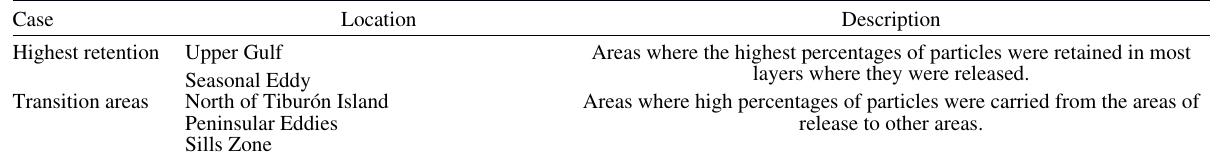
Table 2. – Four cases inferred from the retention matrix.